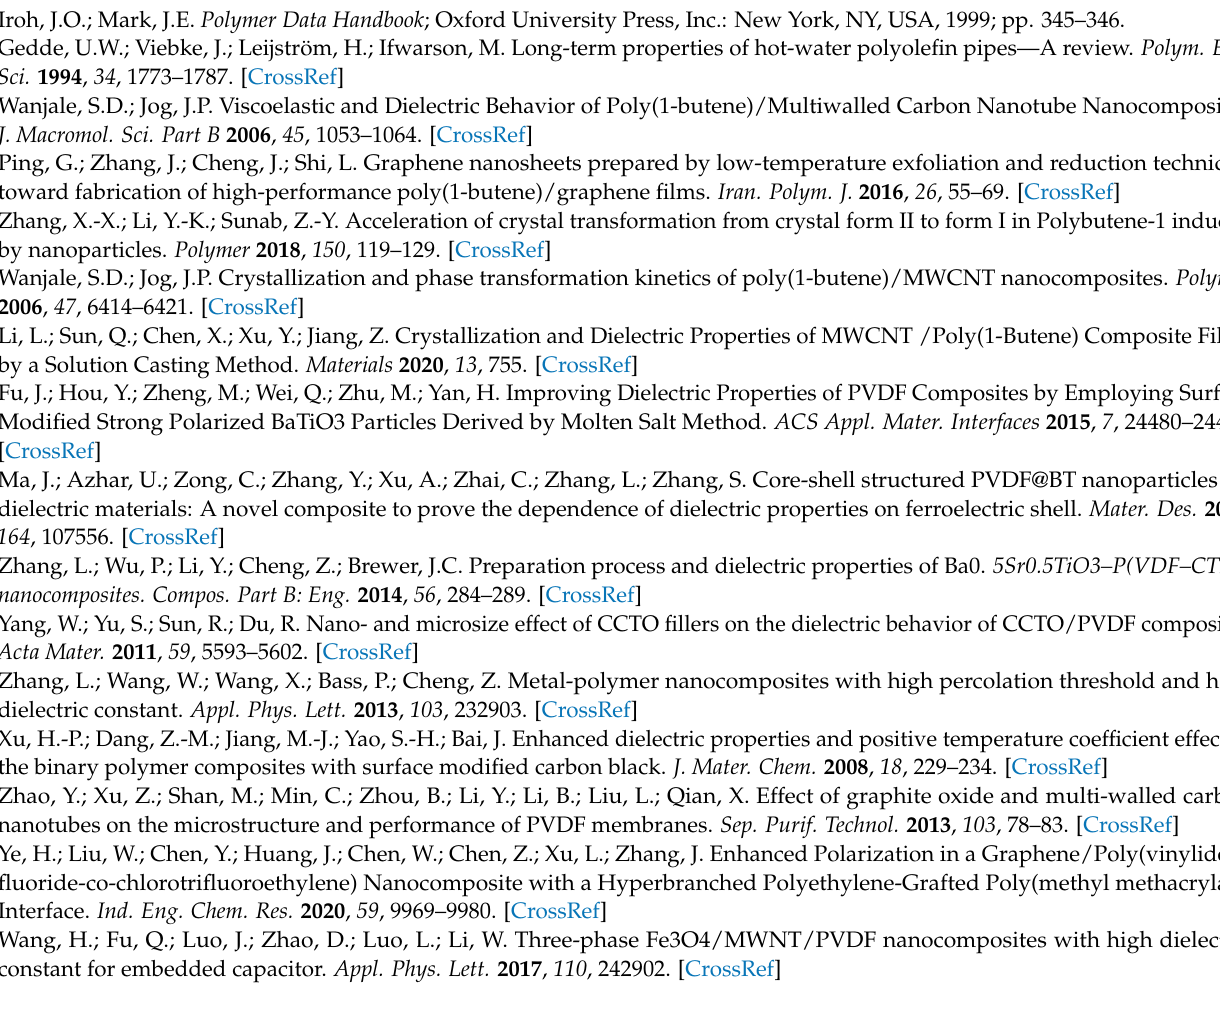
Figure S3. Variation in (a) dielectric constant and (b) dielectric loss with frequency shown by the BZT/PB-1 composite films with different BZT contents. (c) Effects of the addition of different contents of BZT on the breakdown performance of the composite films; Table S1. Melting and crystallization parameters derived from the DSC measurements for the pure PB-1 and composite films with different